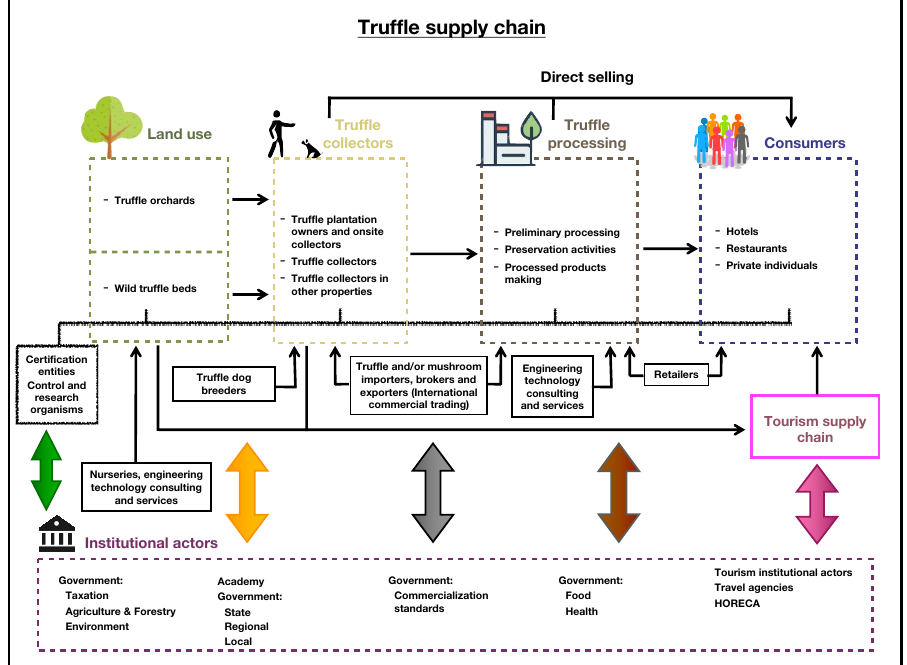
Figure 1. Description of the truffle supply chain developed during the INCREdible events and validated by the truffle panel